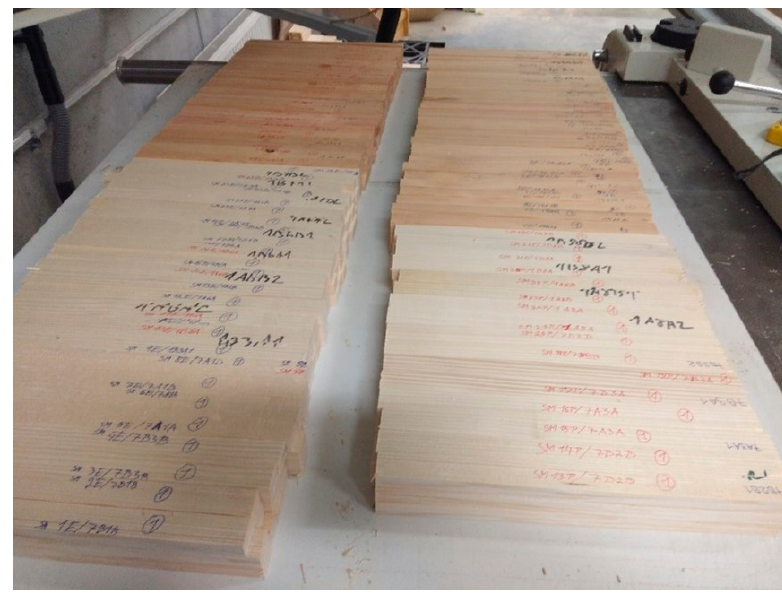
Figure 2. Glued wood